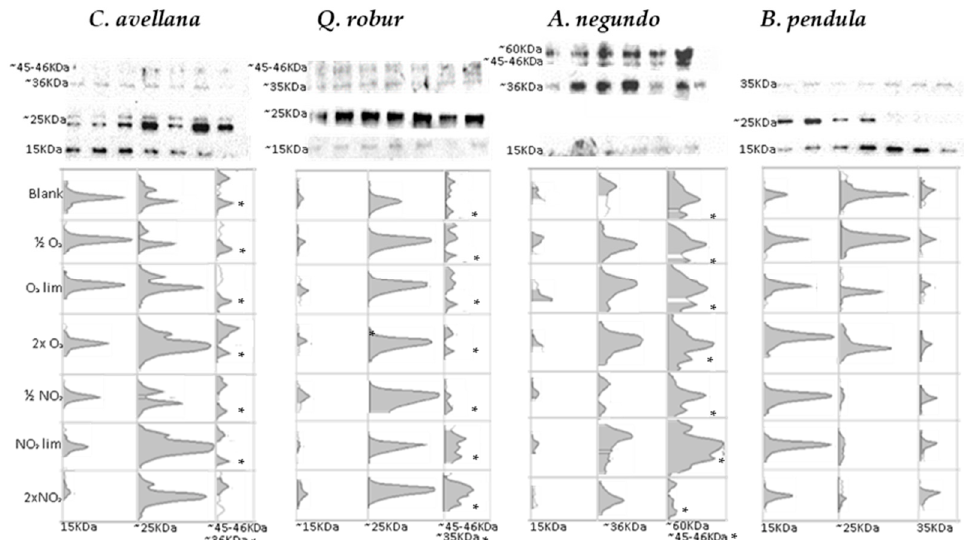
Figure 1. Immunodetection of SOD enzymes in pollen protein extracts (10 µ g per lane) from A. negundo, B. pendula, C. avellana and Q. robur non exposed pollen, blank sample (B) and exposed for 6 h to O 3 and NO 2 at concentrations corresponding to half the limit (1/2), the limit (Lim) and the double limit (2 × Lim) values for the protection of vegetation according to the EU Directive 2008/50/EC on ambient air quality and cleaner air for Europe. Top figures correspond to Western blot probed with a customized anti-olive pollen Cu/Zn SOD Ab (sequence accession n. EU250769.1) and bottom graphics to differences in optical density of reactive bands. "*" aggregates the results of two molecular bands, which are different depending on the